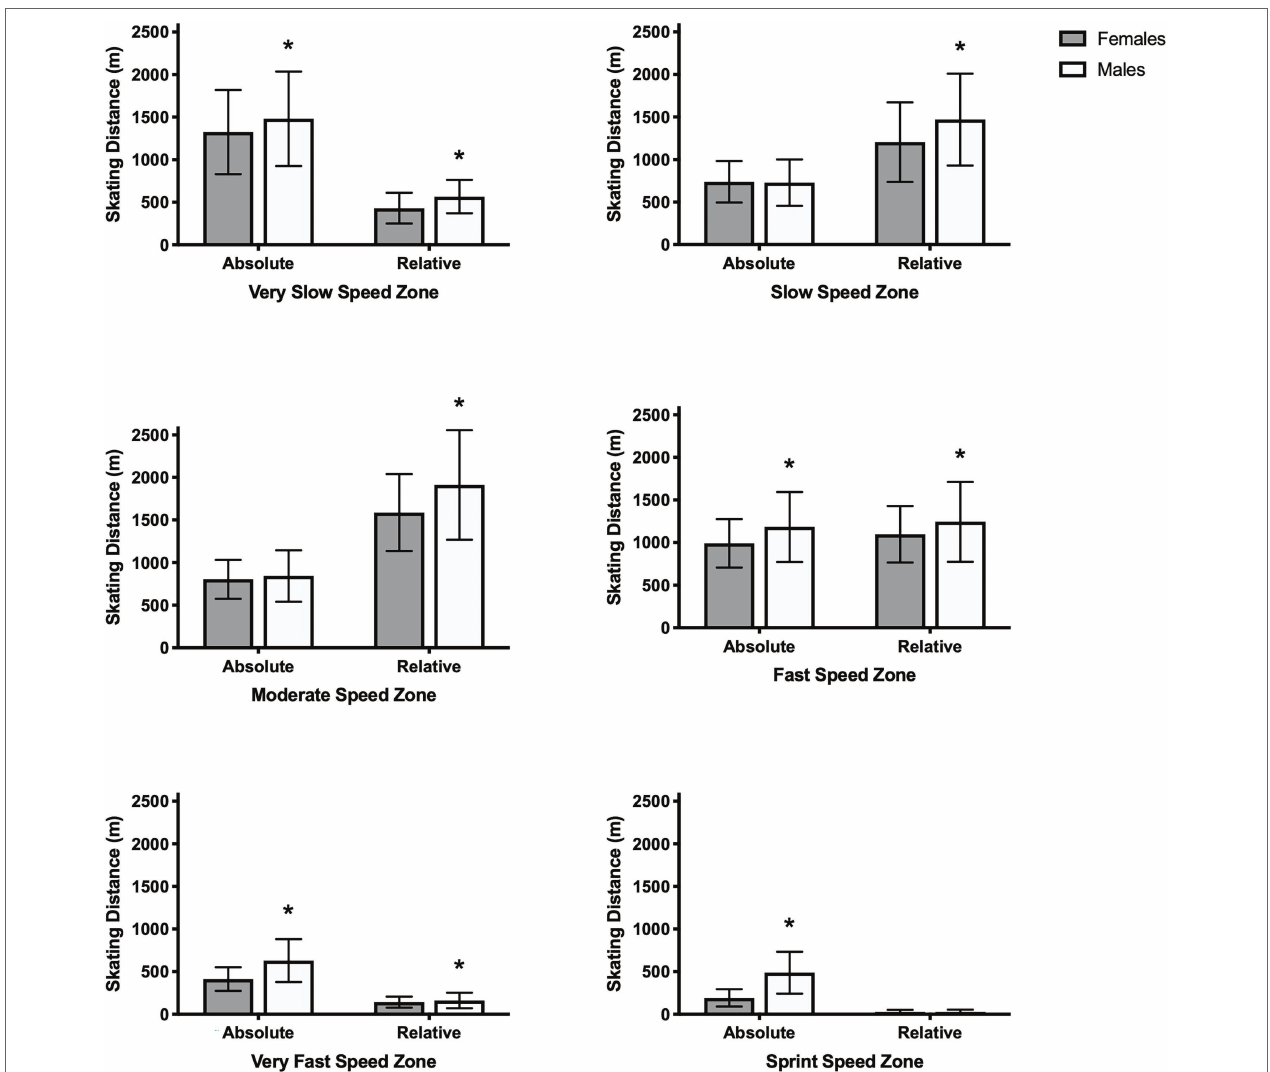
FIGURE 2 | Mean skating distance travelled in very slow (absolute: 1.0–10.9 km/h; relative: <20%), slow (absolute: 11.0–13.9 km/h; relative: 20–39%), moderate (absolute:14.0–16.9 km/h; relative: 40–59%), fast (17.0–20.9 km/h; relative: 60–79%), very fast (21.0–24.0; relative: 80–90%), and sprint (absolute: >24.0 km/h; relative: >90%) speed zones for all female and male ice hockey players. Data are presented as mean ± SD. Absolute and relative skating distances were significantly different within sex for all speed zones ( p < 0.05). *represents a significant difference between skating distances for all females and males within absolute and relative speed zones ( p <